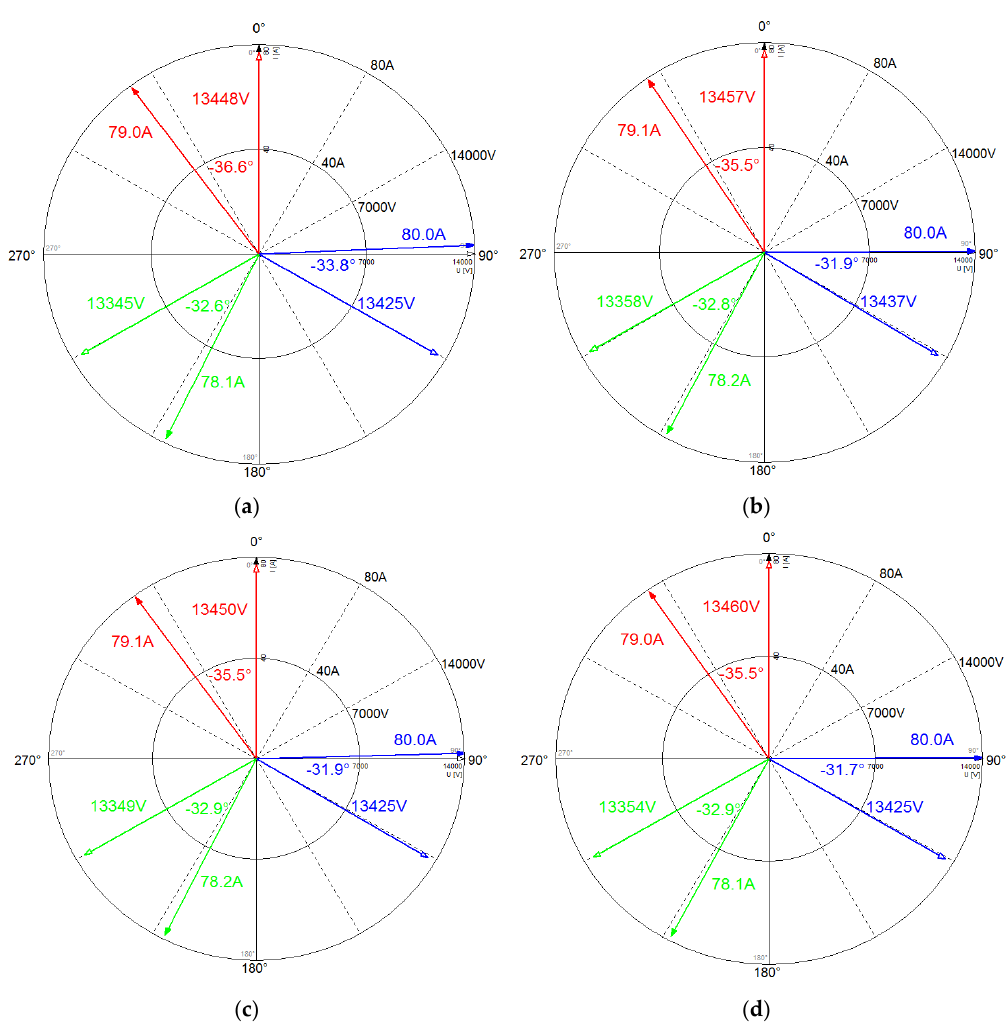
Figure 11. Two-reactor operations ( a ) first ( b ) second ( c ) third ( d )